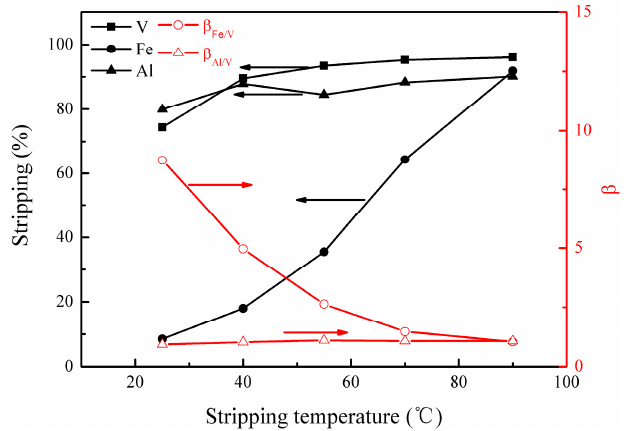
Figure 7. Effect of stripping temperature on the stripping percentages of V (IV), Fe, and Al, as well as on the separation factors β Fe/V and β Al/V .